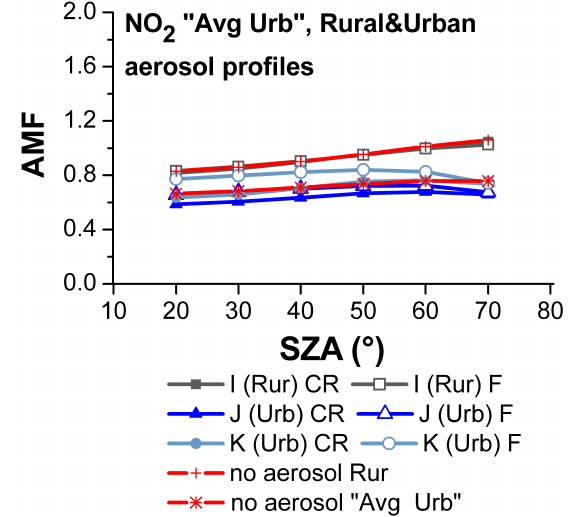
Fig. 8. NO 2 airmass factors for no aerosol (red) cases (rural – Rur - and urban – “Avg urb” – NO 2 profiles from CHIMERE) and for the scenarios I (background – Rur – NO 2 and aerosol vertical profiles), J and K (urban – Urb – NO 2 and aerosol vertical profiles) calcu- lated with the phase functions determined for coarse (CR) and fine (F) particles (optical properties taken from Creteil/Paris AERONET station). AMFs determined at 440nm, with surface albedo = 0.03, ω 0 = 0.93 (I, K) and 0.87 (J), and AOD = 0.07 (I), 0.40 (J) and 0.62 (K) (see Table